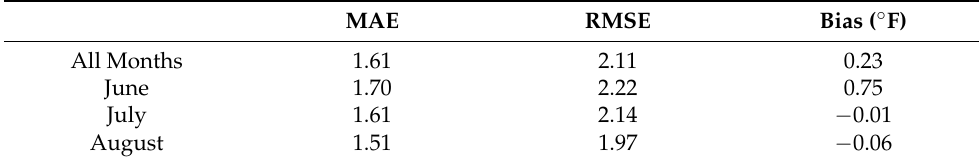
Table A4. Performance metrics averaged across the 10-fold